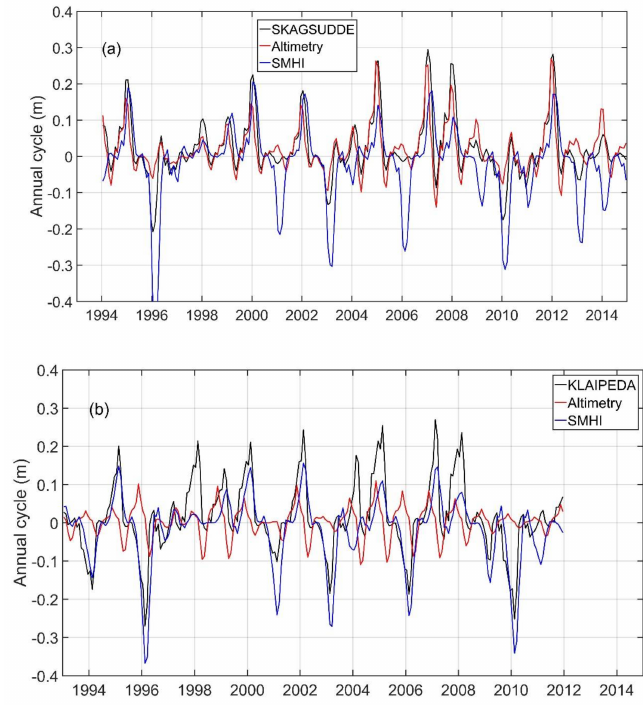
Figure 12. Annual sea level estimated at ( a ) Skagsudde (1994–2014) and ( b ) Klaipeda (1993–2011) using the CSEOF first mode for tide gauge, altimetry data and SMHI